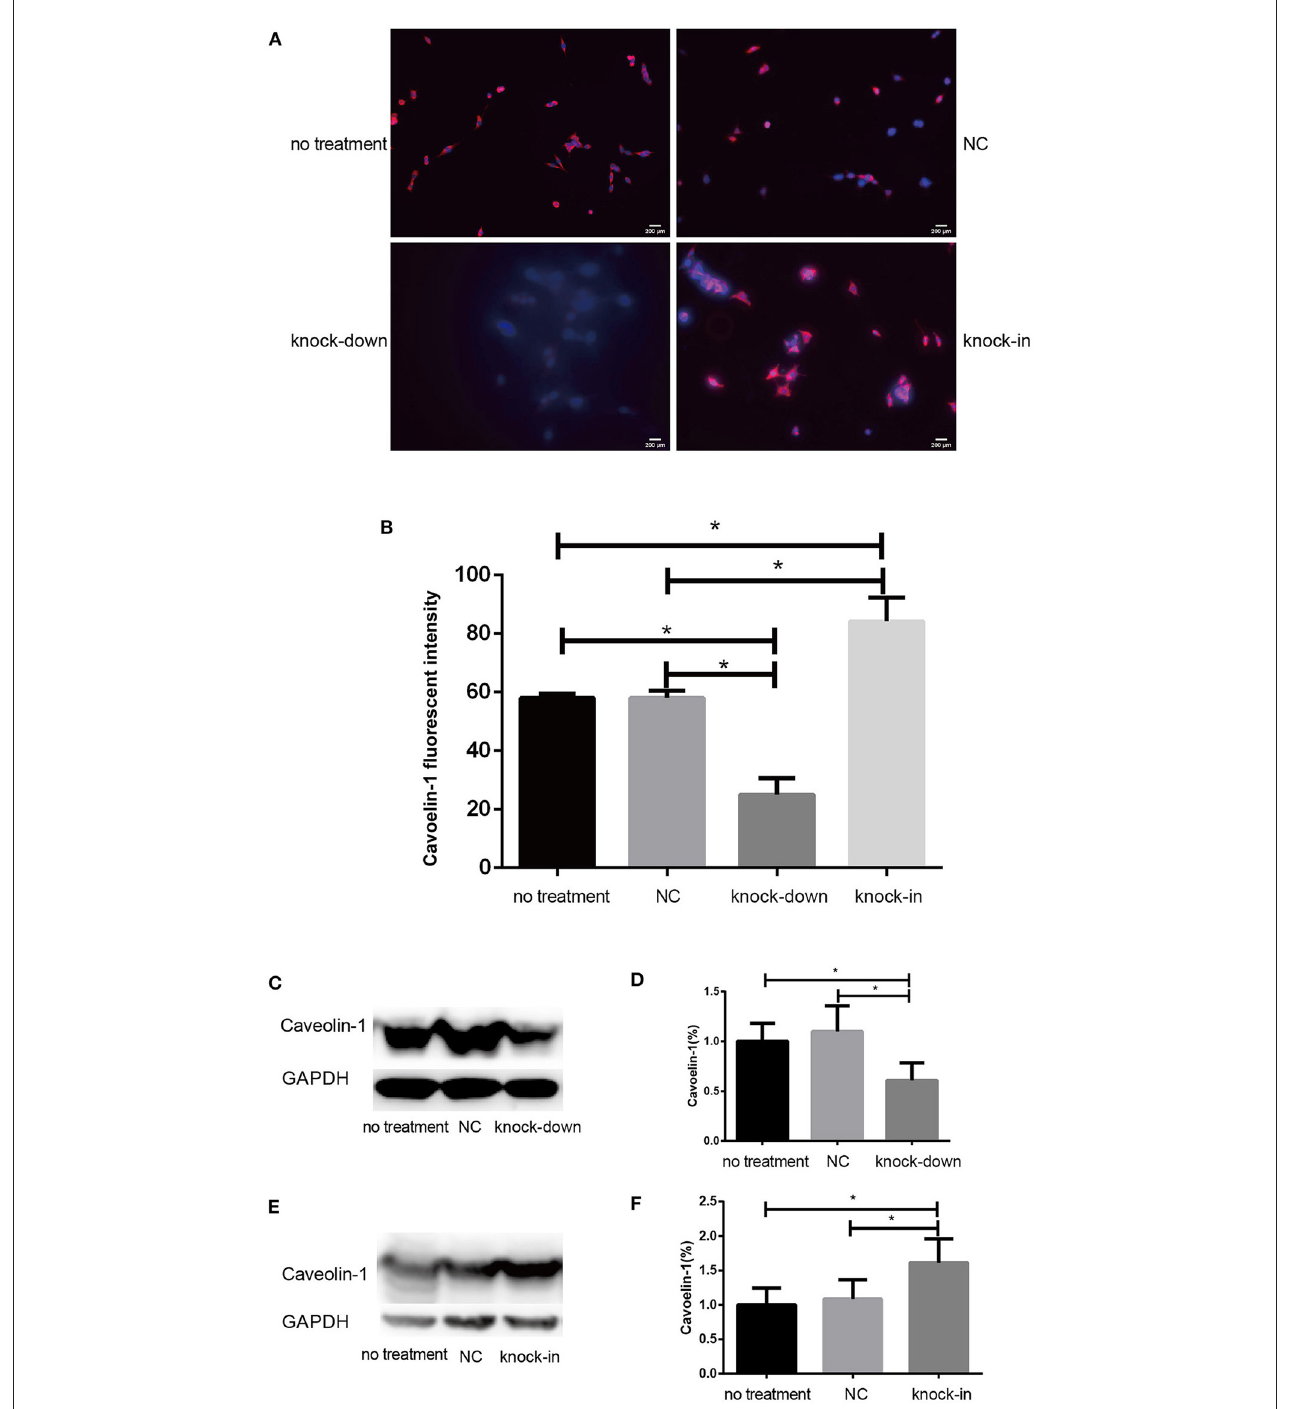
FIGURE 5 | DHCR24 knock-down lead to downregulation of caveolin-1 in plasma membrane caveolae in SH-SY5Y cells. (A) Immunofluorescence studies showing staining of caveolin-1 in SH-SY5Y cells. Scale bar = 200 µ m. (B) The fluorescence intensities of caveolin-1 were quantified and presented as the mean of IOD of Caveolin-1 immunofluorescence intensity. (C,D) Western blots of caveolin-1 from DHCR24 knock-down SH-SY5Y cells. (E,F) Western blots of caveolin-1 from DHCR24 knock-in SH-SY5Y cells. All the data are presented as mean ± SD of at least three individual experiments ( n = 3). * P < 0.05, ** P < 0.01; vs. the no treatment and NC group. caveolin-1, in red-fluorescence; DAPI, in blue-fluorescence ( Figures 2M , 5C share one loading control).